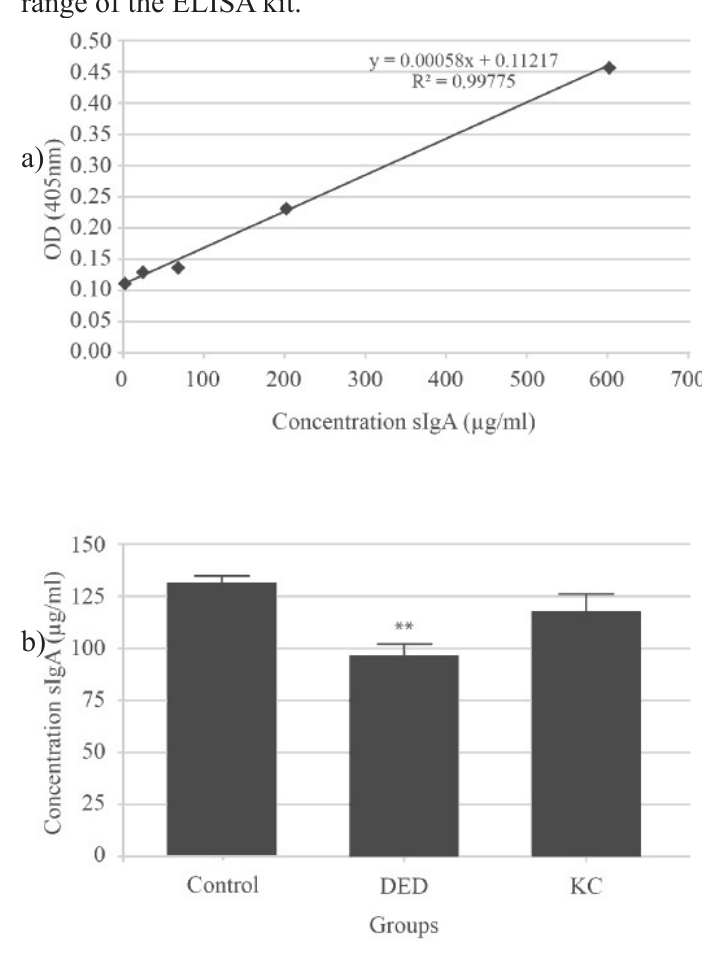
Figure 2 Tear sIgA levels in control, DED and KC